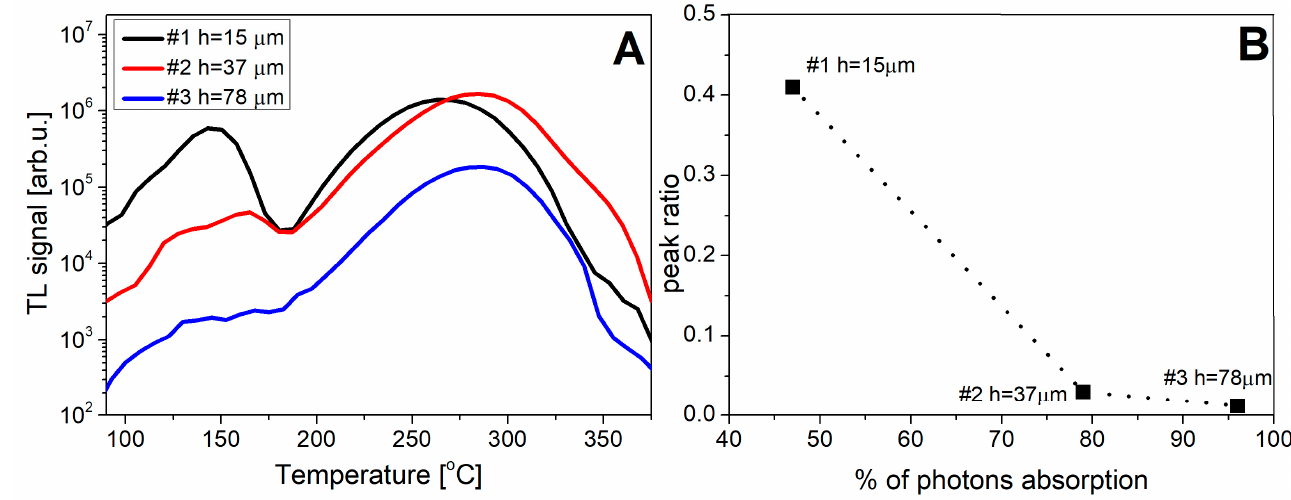
Figure 9. The emission spectra of sample #3 ( panel A —after irradiation with 15 kV X-rays) and panel C —after irradiation with 90Sr/90Y) and TL glow curves ( panels B , D ). TL glow curves are taken from the spectral measurements.